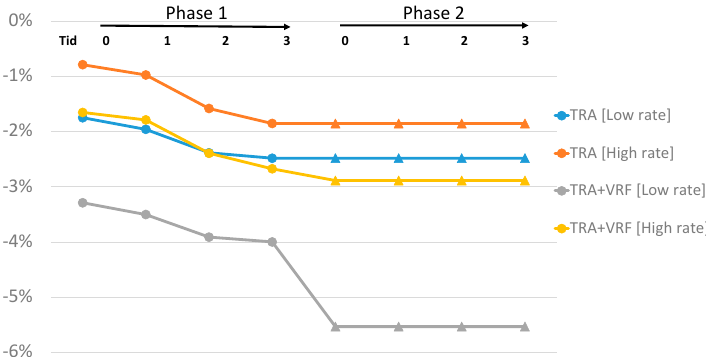
Figure 8. BDBR performance of TRA on training dataset for class B(1080p) at Phase 1 with Δ𝑄𝑃 ∈ {±1,0} and Phase 2 with Δ𝑄𝑃 ∈ {±2, ±1,0} , only one iteration is used.